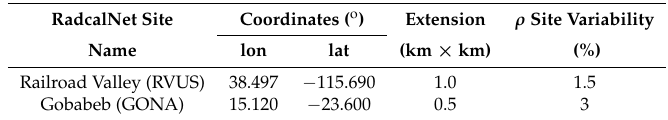
Table 10. RadcalNET sites used for BOA surface reflectance study with their corresponding coordinates, extension and surface reflectance variability across site